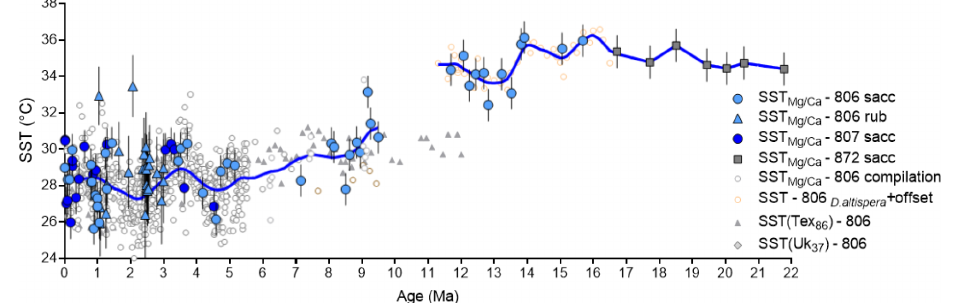
Figure 4. Compilation of temperatures from Site 806 in the WEP. Mg / Ca-based temperatures were derived using the same framework (see Supplement). Blue filled symbols are from Sites 806 and 807 with blue circles for T. sacculifer and triangles for G. ruber ; filled gray squares are data from Site 872 (Sosdian et al., 2018). Open symbols are SST derived from Mg / Ca at Site 806 (Wara et al., 2005; Tripati et al., 2009; (cid:48) Nathan and Leckie, 2009). Tex 86 and U K are also plotted for comparison (Zhang et al., 2014). Orange open circles are SST data calculated 37 with our framework from the species D. altispera at ODP Site 806 (Sosdian et al., 2020) with an offset of + 8 ◦ C. Blue line is a smooth line (LOWESS) going through the data.